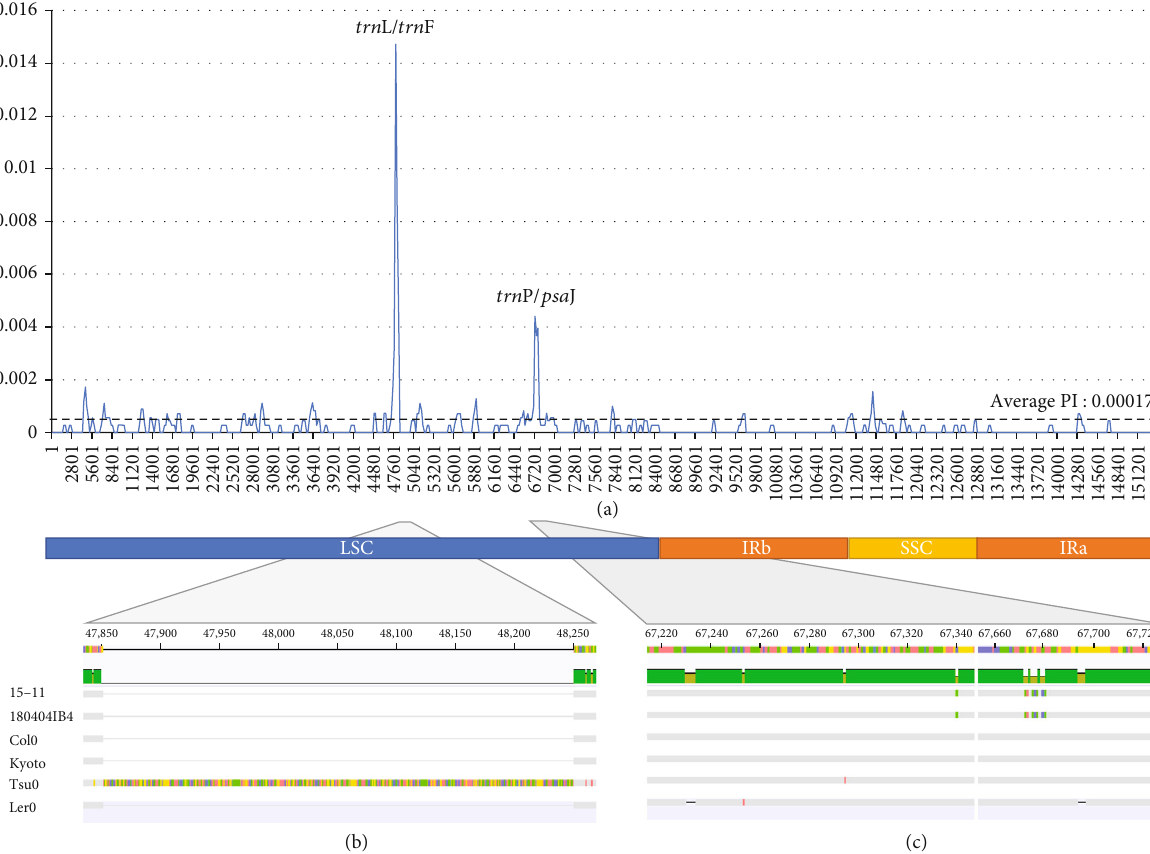
Figure 5: Nucleotide diversity analysis of Arabidopsis thaliana chloroplast genomes. (a) X -axis means the coordination of alignment of A. thaliana chloroplast genomes and Y -axis indicates the nucleotide diversity (pi value). Black dotted line means the average value of pi. Three colored boxes show regions of chloroplast genome: LSC, SSC, and IR regions. (b) Enlarged diagram of alignment between 47,830 and 48,280. (c) Two regions between 67,200 and 67,360 and between 67,640 and